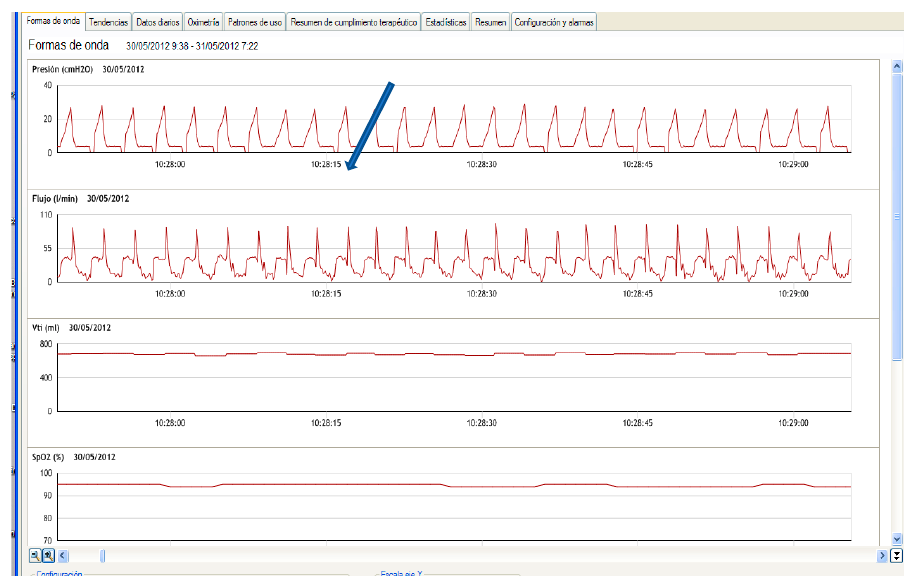
Figure 2. Example of a built-in software in volume mode and a single limb system with active valve. Channel 1: Pressure, Channel 2: Flow. The arrow is indicating the flow increase corresponding to the active valve opening. Channel 3 corresponds to the estimated tidal volume and channel 4 to the oxygen saturation.